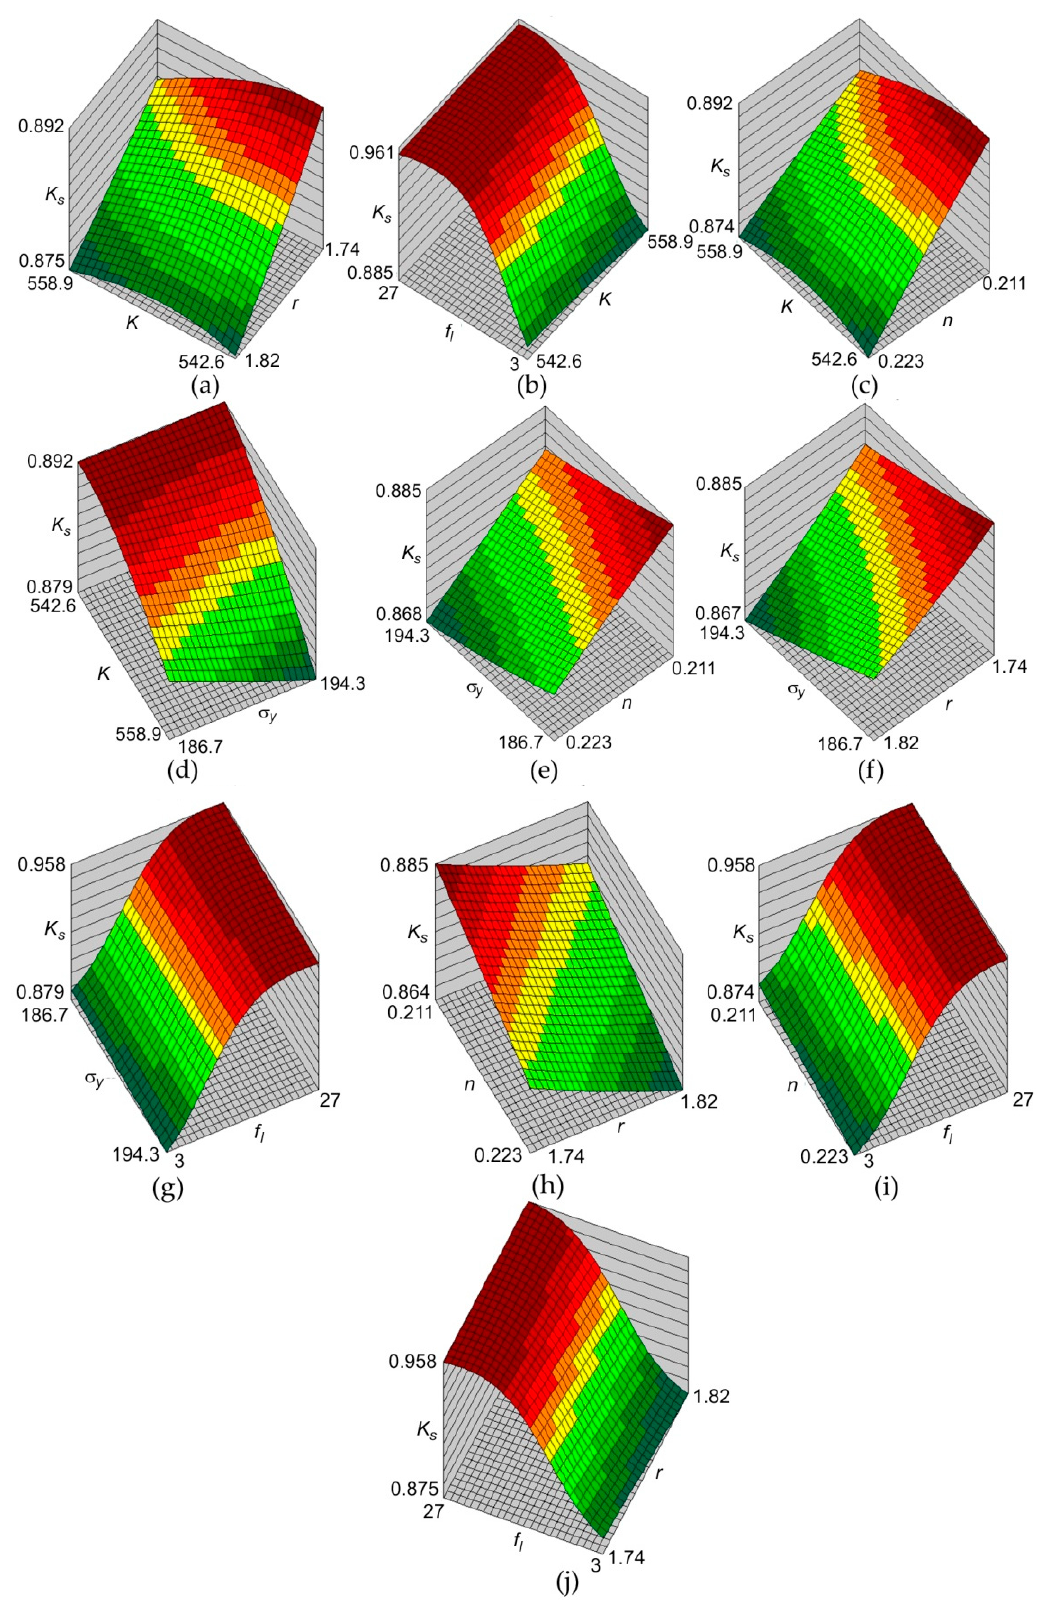
Figure 7. The effect of combinations of ( a ) K and r , ( b ) F l and K , ( c ) K and n , ( d ) K and σ y , ( e ) σ y and n , ( f ) σ y and r , ( g ) σ y and f l , ( h ) n and r , ( i ) n and f l and ( j ) f l and r on the value of springback coefficient K s .